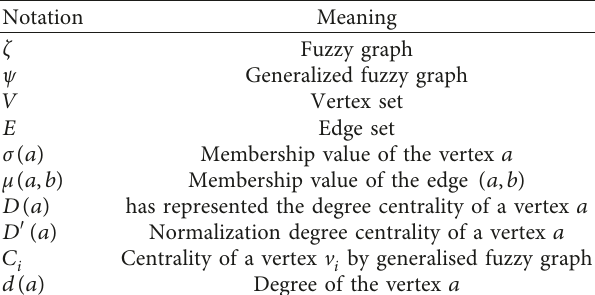
Table 1: Some basic